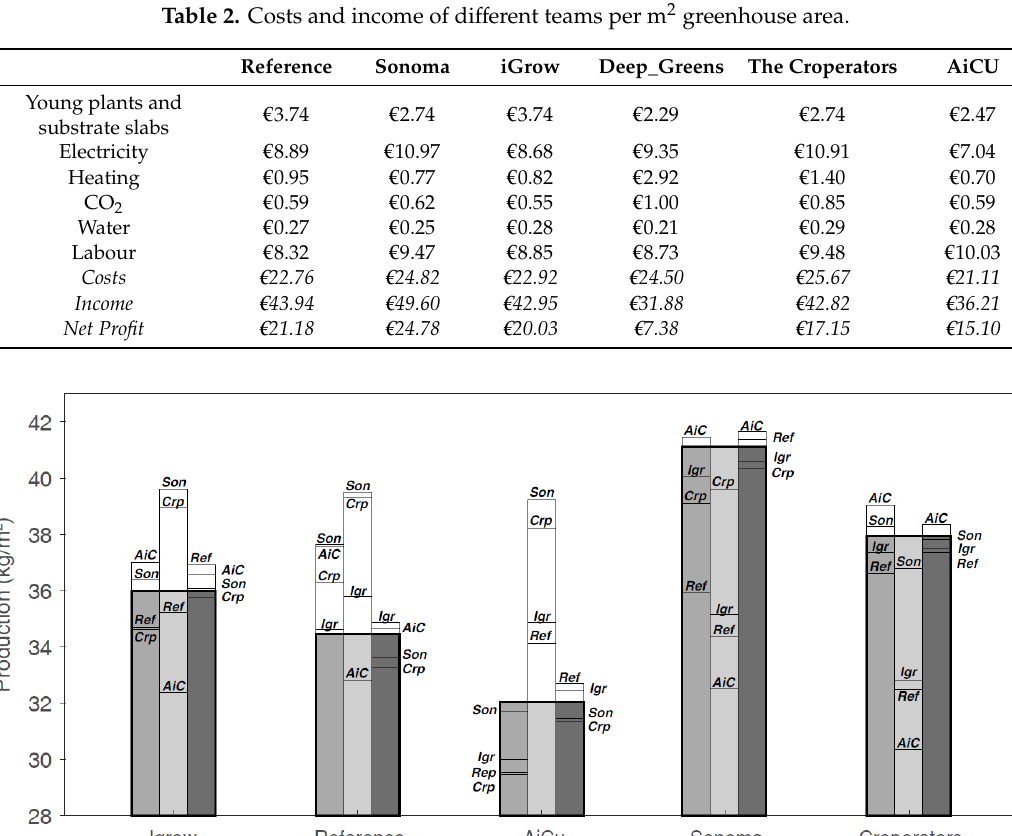
Figure 13. Realized cucumber production (greyscale bars) and predicted cucumber production per greenhouse compartment of different teams (iGrow, Reference, AiCU, Sonoma, The Croperators), using the cropping (1st bar), lighting (2nd bar), or CO 2 (3rd bar) strategy of each of the other teams. Solid lines within the greyscale bars indicate lower production than that realized by the team, whereas the top colorless bars represent higher predicted production, e.g., team iGrow realized a cucumber yield of approximately 36 kg/m 2 ; with the lighting strategy of Sonoma (but same climate and cropping strategy) they could have realized a yield of approximately 40 kg/m 2 , while with the lighting strategy of AiCU, it would have been only approximately 33 kg/m 2 .